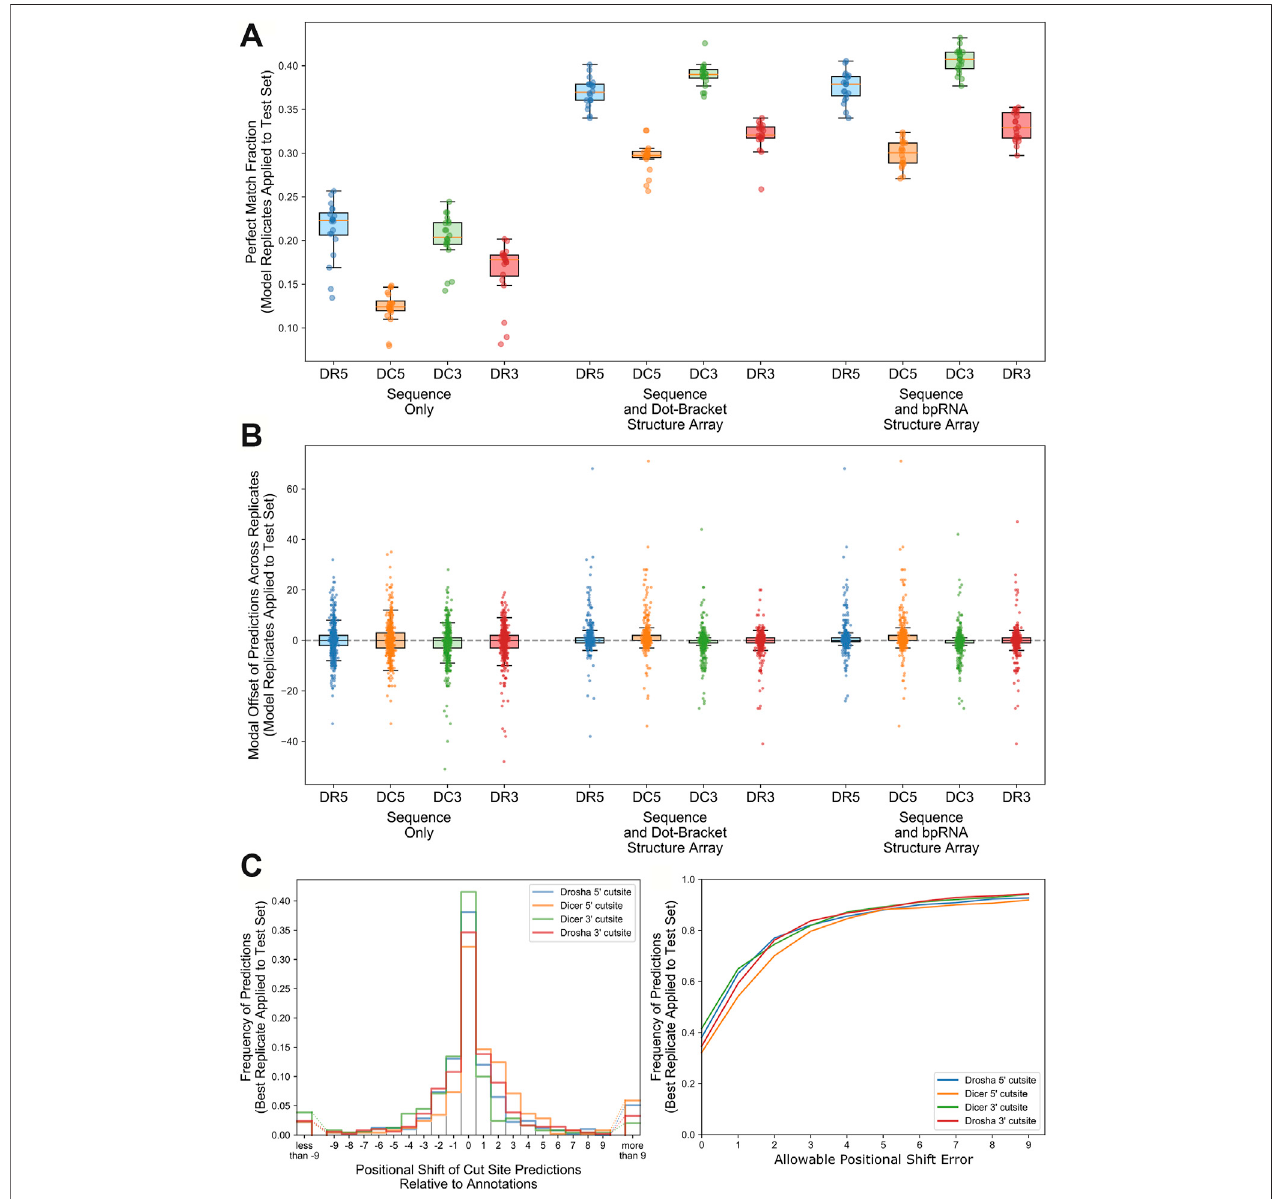
FIGURE3| Comparisonofperformance forreplicates trainedwiththebestparametercombinationsforeach inputtype. (A) .Boxplotcomparingtheperfectmatch fraction found when each model replicate was run against the test set. (B) . Boxplot showing the modal offset of each prediction across all model replicates. (C) . Histogram showing the frequency of positional shifts of predicted cut sites relative to their annotated locations for the best replicate trained using nucleotide, RNAfold, and bpRNA structure array. D. A line plot showing the fraction of cut sites identi fi ed within varying distances from the annotations for the best replicate trained on nucleotide, RNAfold, and bpRNA structure